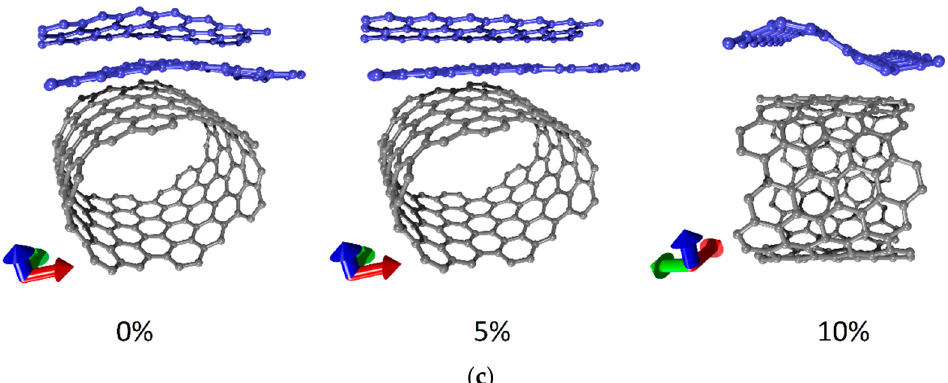
Figure 4. Changes in the atomic structure of supercells of hybrid films formed by bilayer graphene and SWCNTs (12, 6) upon axial stretching: ( a ) model V3; ( b ) model V2; ( c ) model V1.